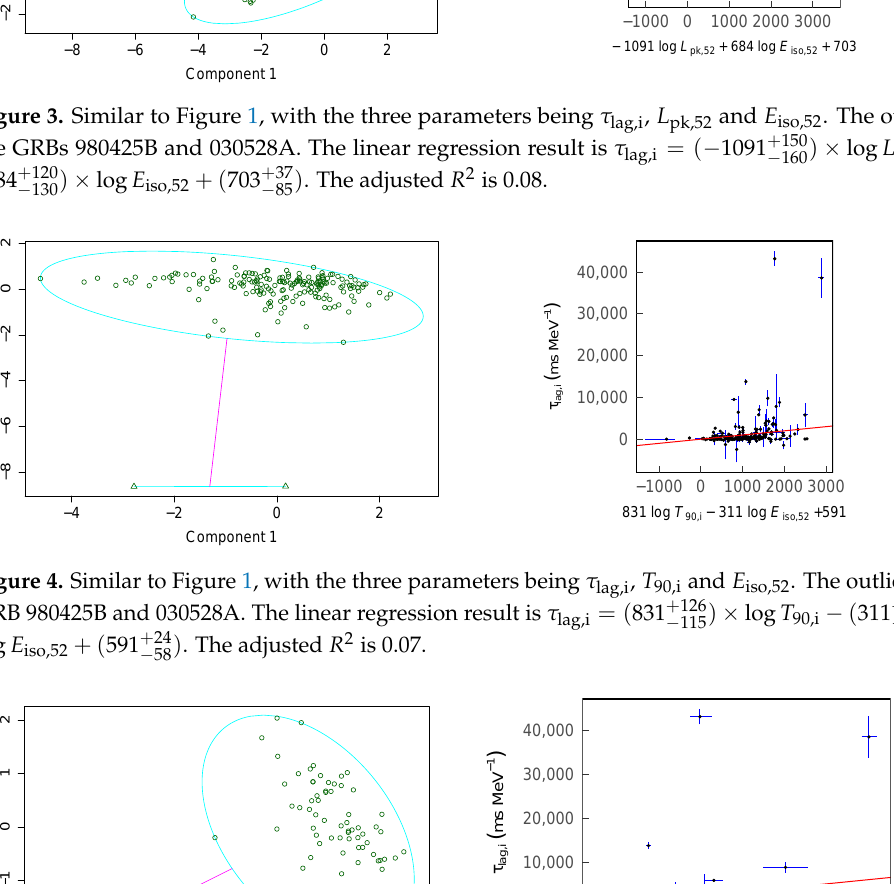
) × log L + pk,52 160